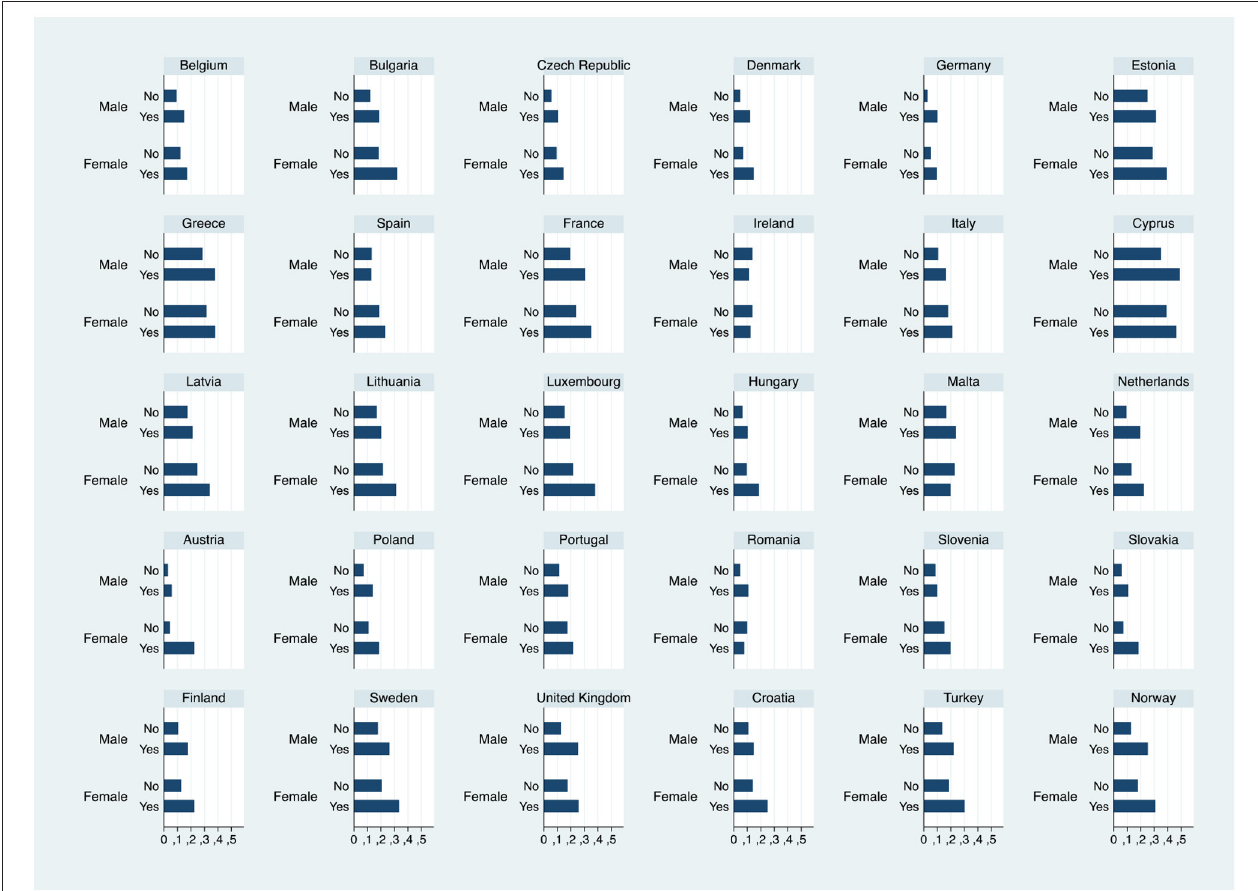
FIGURE 1 | Proportion of workers who report anxiety, by job insecurity perception, gender, and